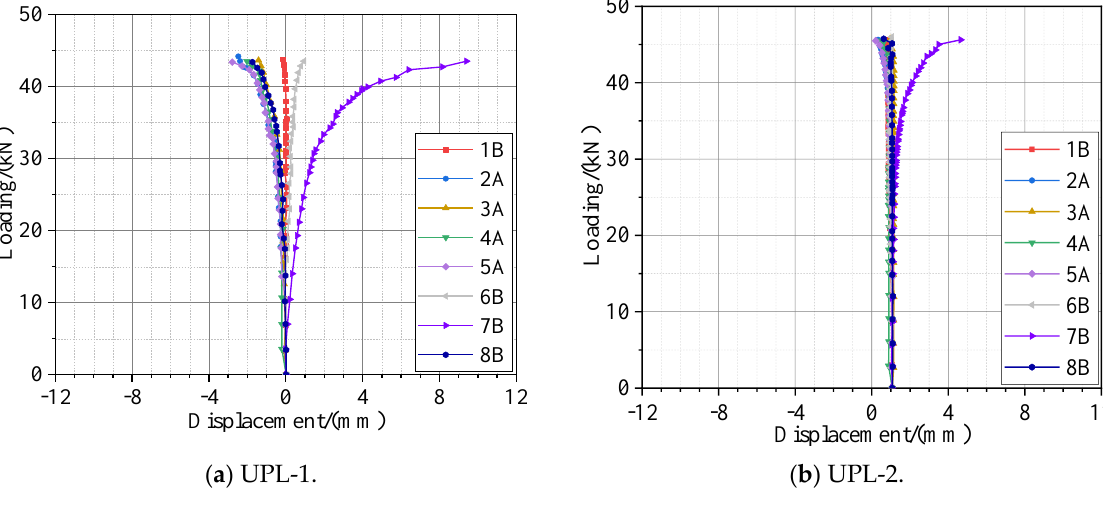
Figure 15. Deformation of specimen UTW-1.